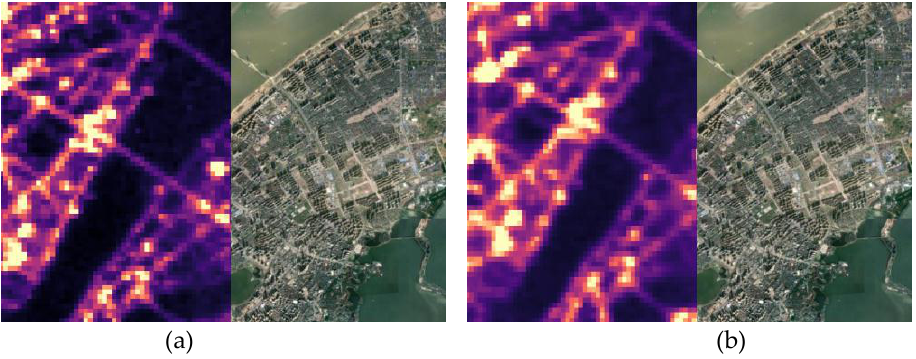
Figure 3. The geolocating performance of LuoJia1-01 nighttime light imagery: ( a ) refers to the performance before ortho-rectification; ( b ) refers to the performance after geometric correction.